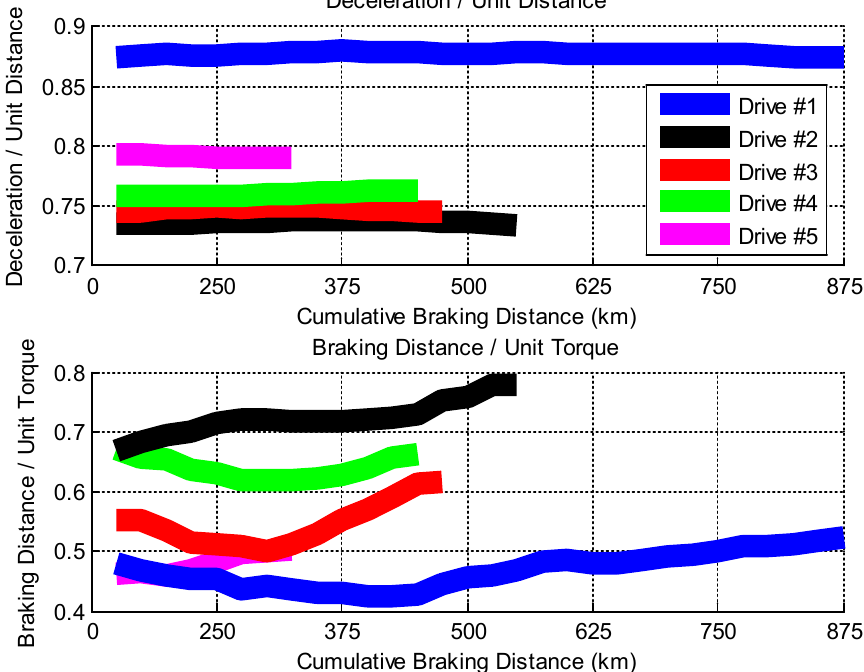
Figure 14. Upper plot shows X decel _ pref , which is the first type of deceleration attribute. Lower plot shows X decel _ ef fi (lower) which is the second type of deceleration attribute.